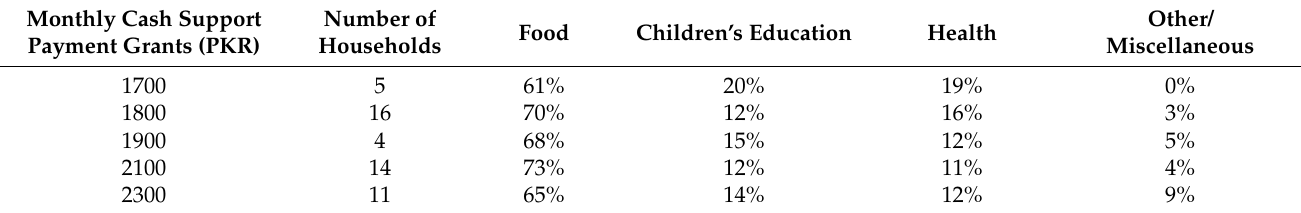
Table 3. Monthly cash support spending patterns in beneficiary